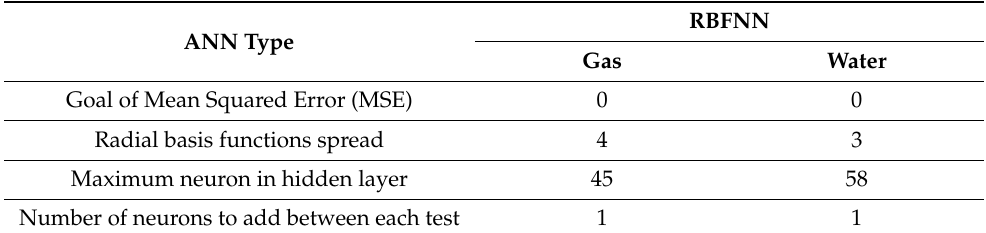
Table 2. Configuration of gas and water volume fraction predictor network.